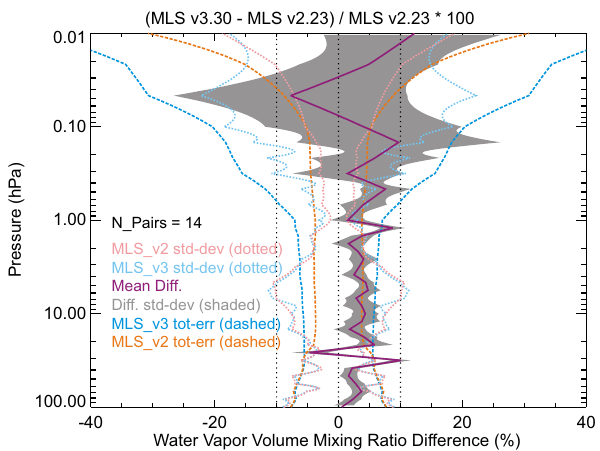
Fig. 12. Water vapor mixing ratio differences (%) between Aura- MLS v2.23 and Aura-MLS v3.3, during MOHAVE-2009.